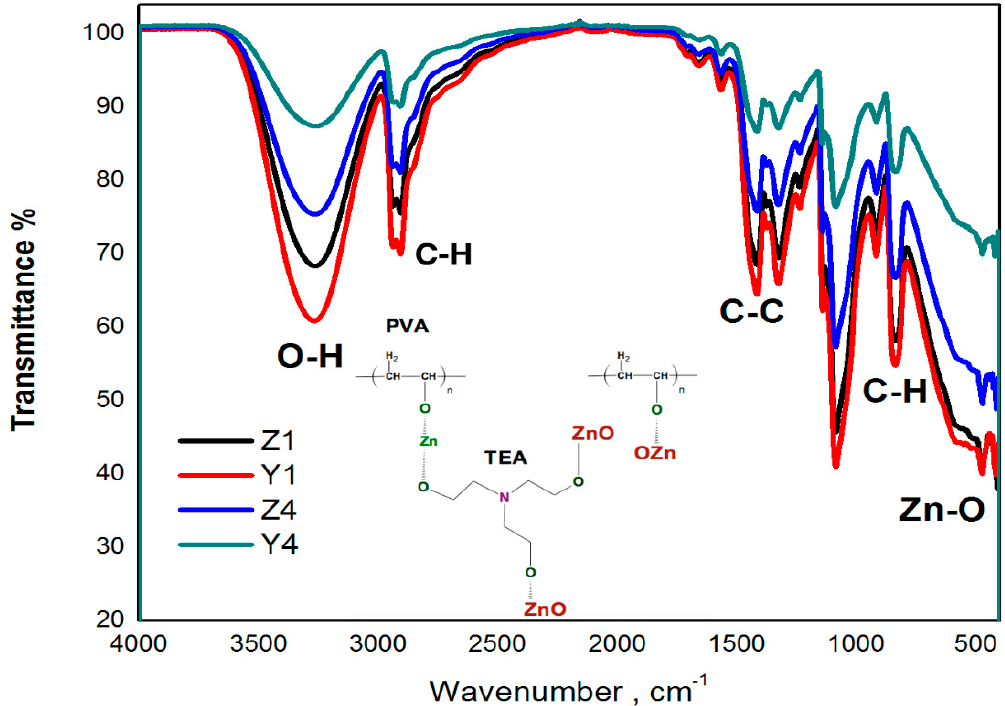
Figure 3. FTIR spectra of PVA matrix with ZnO nanoparticles, the inset shows the reaction of PVA and ZnO.